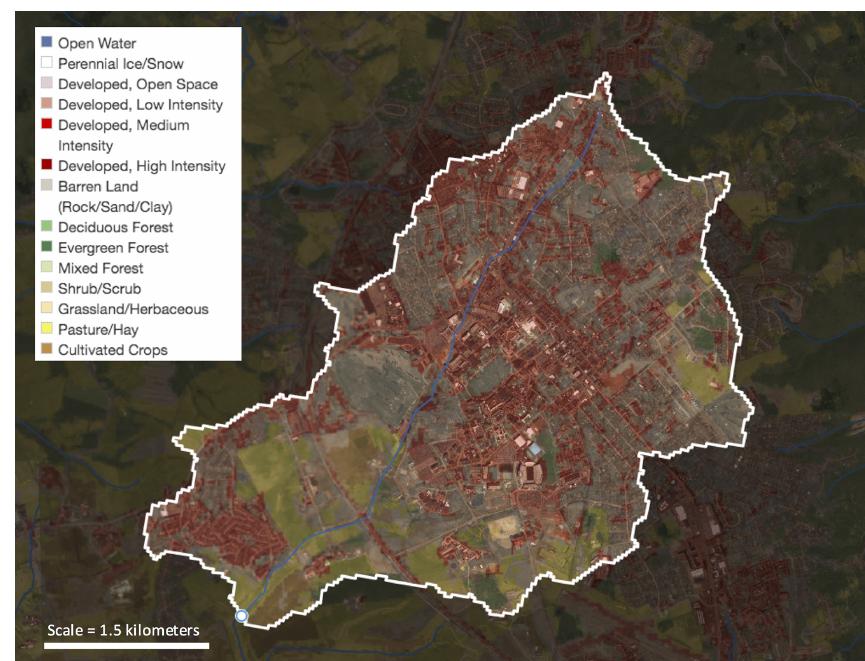
Figure A1. Stroubles Creek watershed and land cover types in the area that drains to the StREAM Lab monitoring site at Bridge 1, Blacks- burg, VA, USA (coordinates in decimal degrees: 37.21013, − 80 . 44511). The nearby weather station that provided light and barometric pressure is just west of the watershed boundary and within the same valley. We created this map using ArcGIS, NHDplus version 2.1, and the US Geological Survey’s 2011 National Land Cover